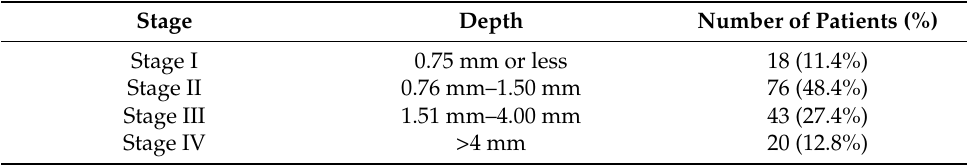
Table 1. Breslow